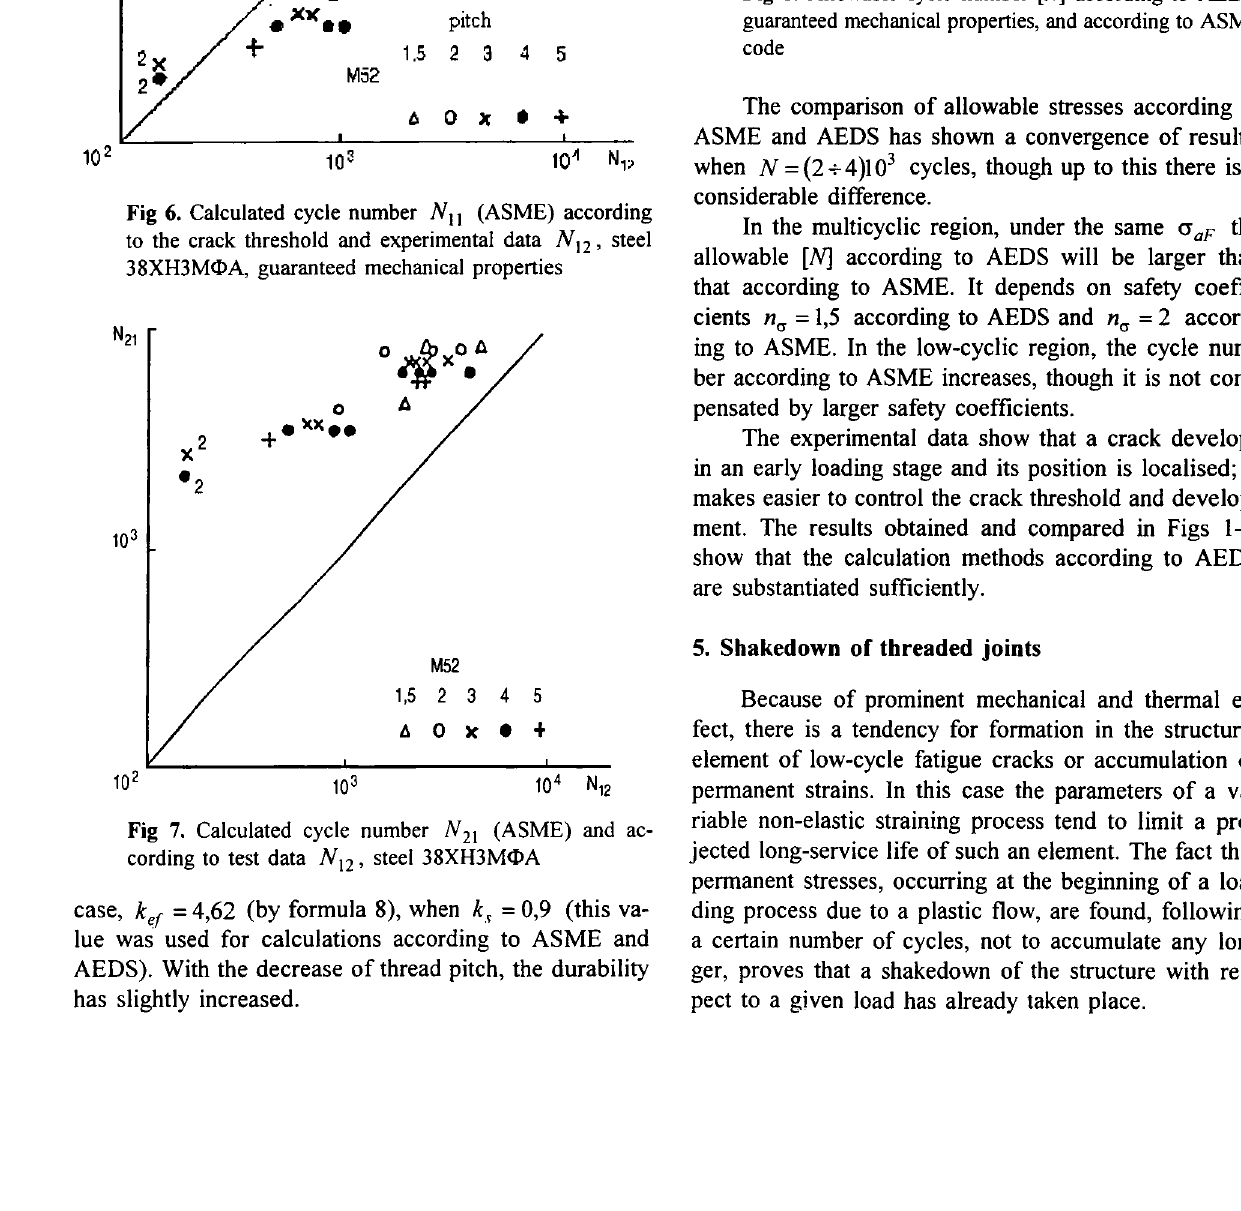
Fig 5. Calculated cycle number N to the crack threshold and experimental data N 38XH3M<l>A, real mechanical properties